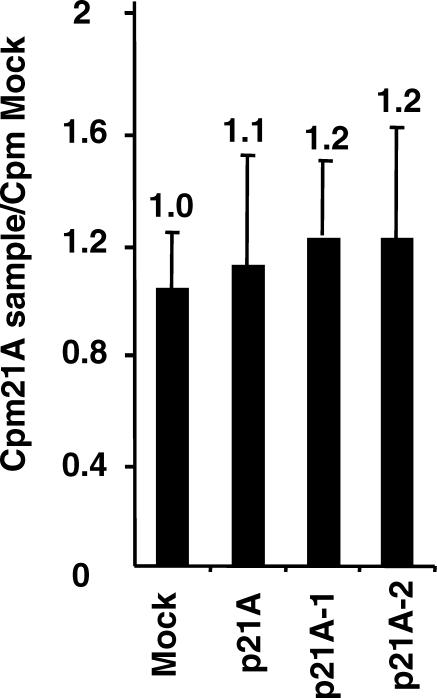
Mouse NIH-3T3 Cell Proliferation Rate after Transfection of 21A ConstructsNo proliferation decrease was observed.